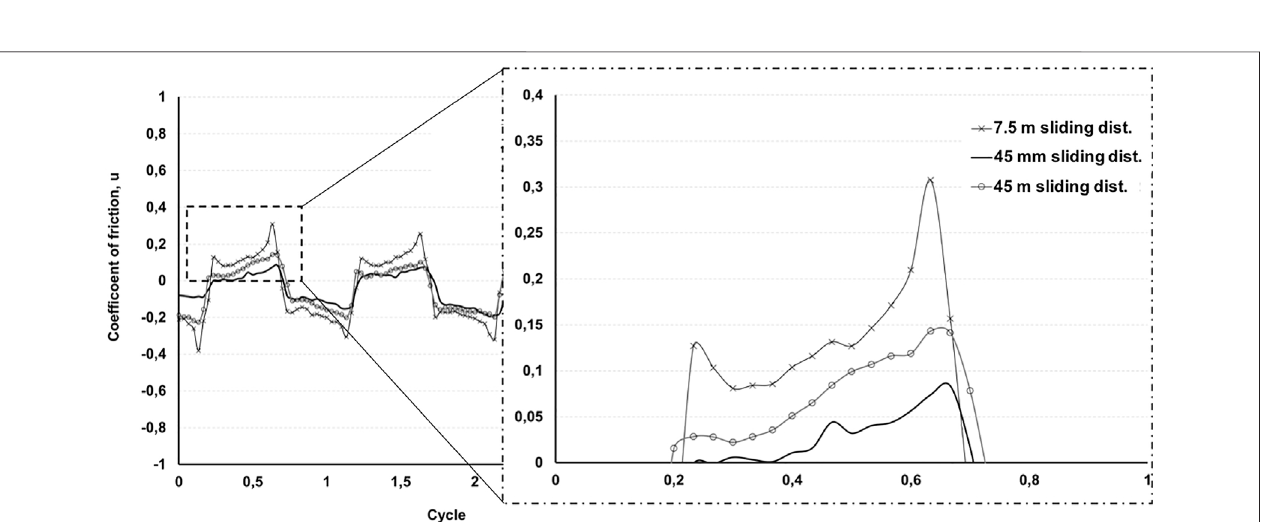
Frontiers in Mechanical Engineering |